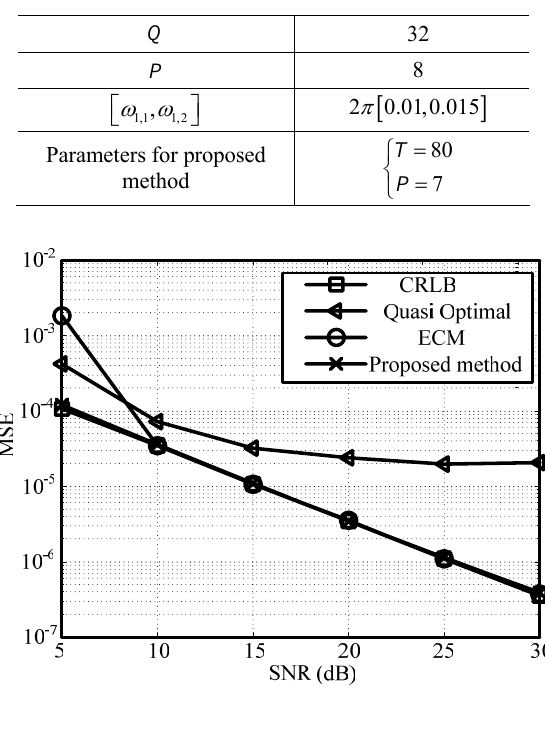
Fig. 3. Performance of different optimization